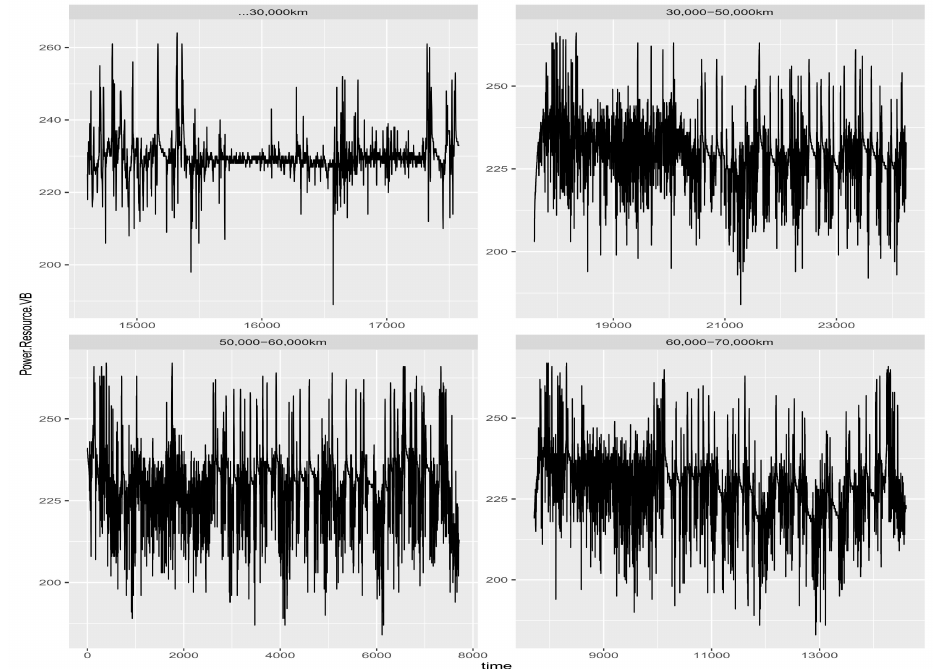
Figure 3. The time-series plot of power resource voltage of battery according to mileage intervals